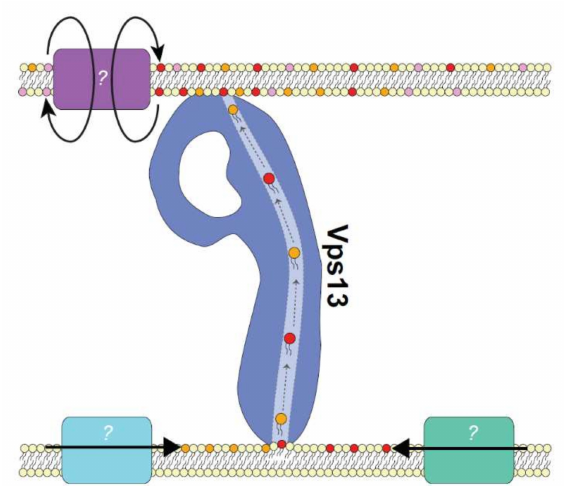
Figure 3. Proposed mechanism of VPS13 lipid transport at membrane contact sites. Unidirectional transport of bulk lipids by VPS13 proteins may be driven by localized lipid synthesis at donor membranes and scramblase activity on acceptor membranes. Putative lipid synthesis enzymes are shown in teal and green. These enzymes, which may or may not be coupled directly to VPS13 proteins, could provide a source of newly synthesized lipids for bulk transport. A putative scramblase at the acceptor membrane is shown in purple. Scramblases that non-specifically translocate lipids between acceptor membrane leaflets allow membrane expansion to occur. XK, a predicted phospholipid scramblase, has been recently shown to interact with VPS13A [56]. Model not to